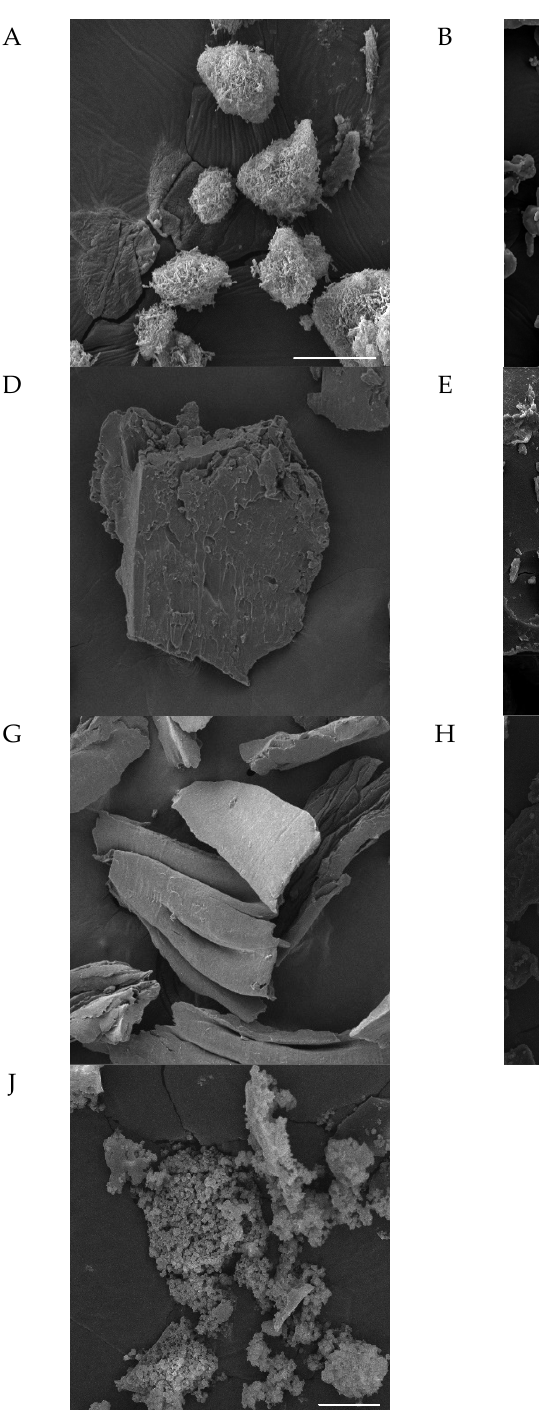
Figure 5. SEM micrograph of ( A ) OA, bar: 20 nm; ( B ) P407, bar: 20 nm; ( C ) PM OA-P407 1:2, bar: 20 nm; ( D ) SEM OA-P407 1:2, bar: 100 nm; ( E ) P188, bar: 20 nm; ( F ) PM OA-P188 1:2, bar: 20 nm; ( G ) SEM OA-P188 1:2, bar: 200 nm; ( H ) γ -CD, bar = 20 nm; ( I ) PM OA- γ -CD 1:2, bar: 10 nm; ( J ) SEM OA- γ -CD 1:2, bar: 10 nm.